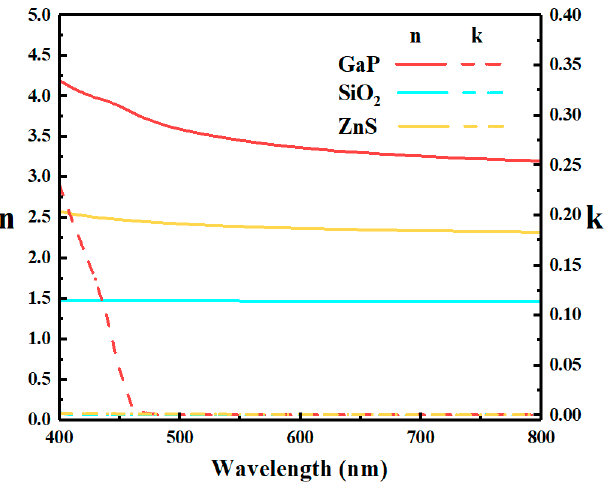
Figure 2. Refractive indices and extinction coefficients of materials used in simulation.